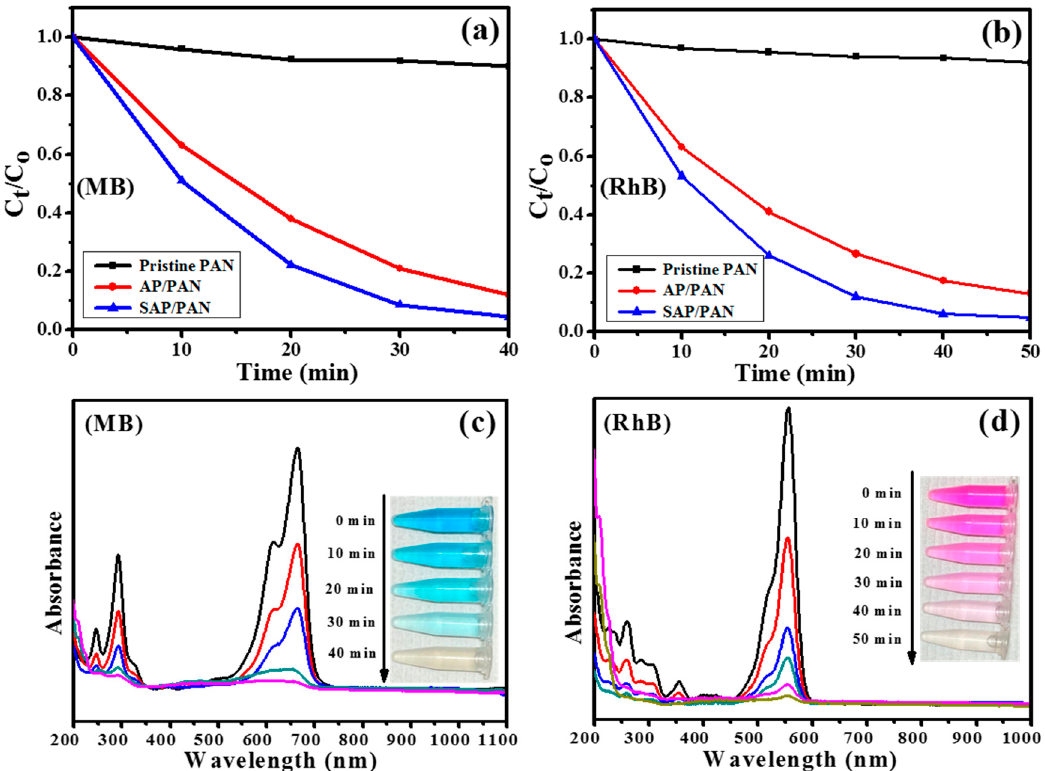
Figure 7. Photocatalytic performances of pristine PAN, AP/PAN, and SAP/PAN towards photodegradation of MB ( a ) and RhB ( b ) solutions. Absorbance variation of MB ( c ) and RhB ( d ) solutions utilizing SAP/PAN. Insets; digital photographs showing the color change of corresponding dye solution with irradiation time.